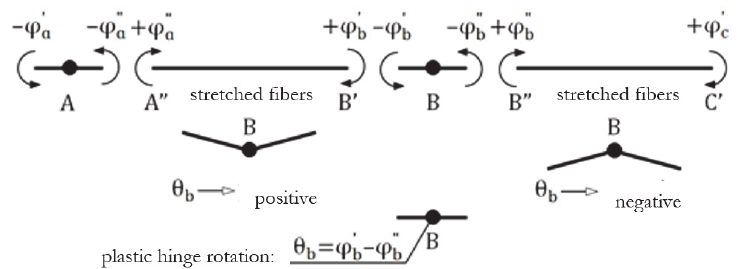
Figure 1: Sign convention.